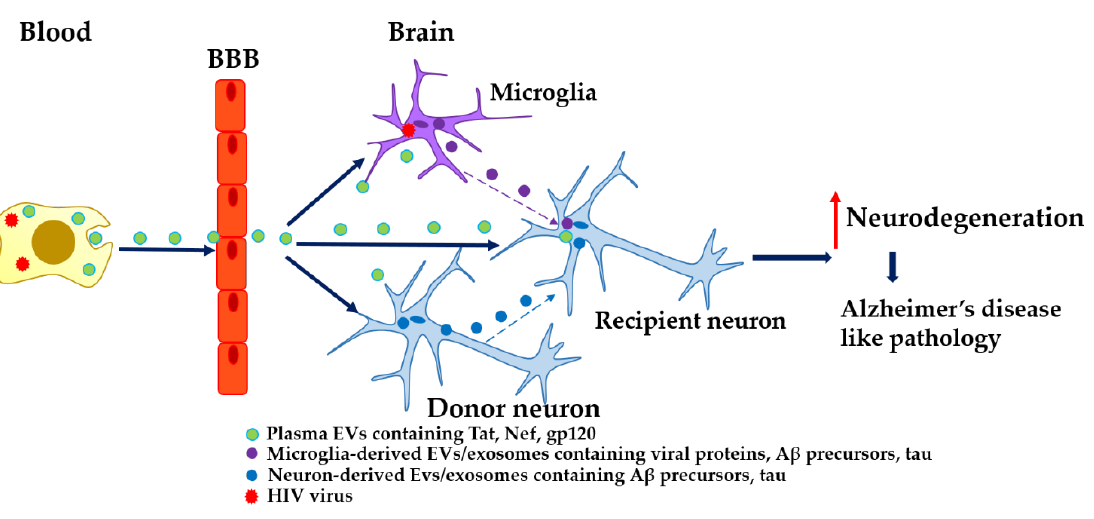
Figure 1. Possible mechanisms of EVs / exosome in propagating HIV-induced Alzheimer’s disease- like pathology. Table 2. HIV elements and A β packaged within EVs / exosomes of CNS